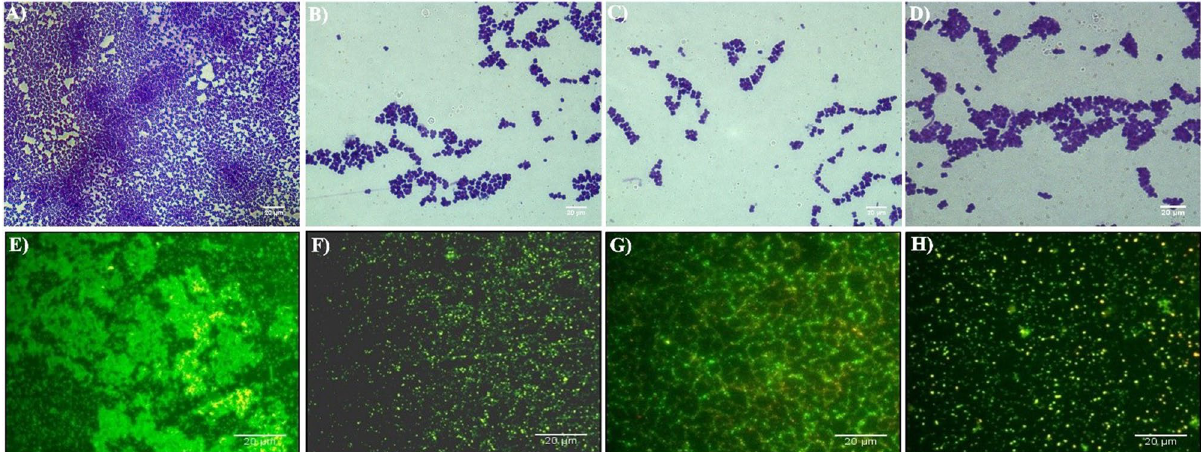
Figure 4. Crystal Violet and fluorescent imaging of Methicillin-resistant S. aureus biofilm. Crystal Violet staining of MRSA biofilms formed on glass surface (A) Untreated-MRSA biofilms (B) KF@AgNPs treated (C) KF@CuNPs treated and (D) Doxycycline treated. Fluorescence Live-Dead Imaging of biofilms formed on glass surface (E) Untreated, (F) KF@AgNPs, (G) KF@CuNPs, and (H) Doxycycline treated images. Live cells are indicated in green and dead cells in red, and the live/dead merged image appears